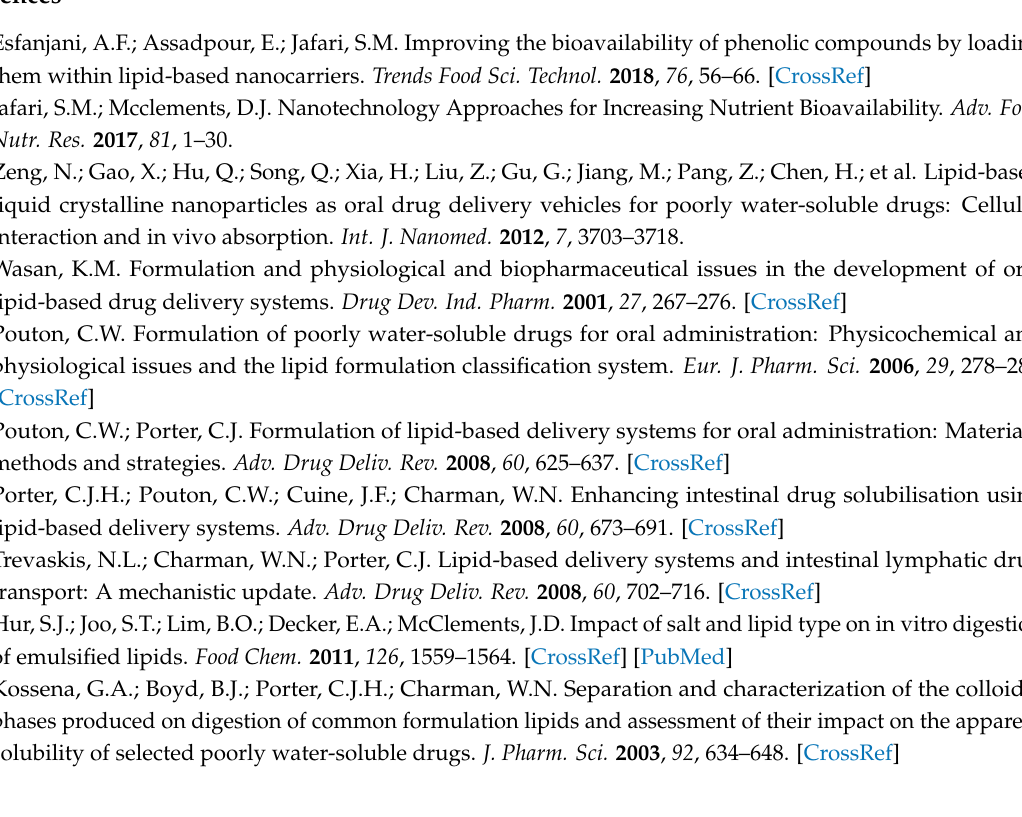
Figure S1. Pseudo-ternary Phase Diagrams: “Me” represented microemulsion area; (A) the mixing ratio of Cremophor RH40 and Transcutol P was 3:1; (B) the mixing ratio of Cremophor RH40 and Transcutol P was 1:1; (C) the mixing ratio of Cremophor RH40 and Transcutol P was 1:3. Figure S2. The microscopic images of the four formulations. Formulations were showed as labeled and the ruler was in the bottom right corner of the diagram. Table S1. Self-emulsifying Time, droplet Size, appearance and solubility of indomethacin for the nanoemulsions (mean, n =